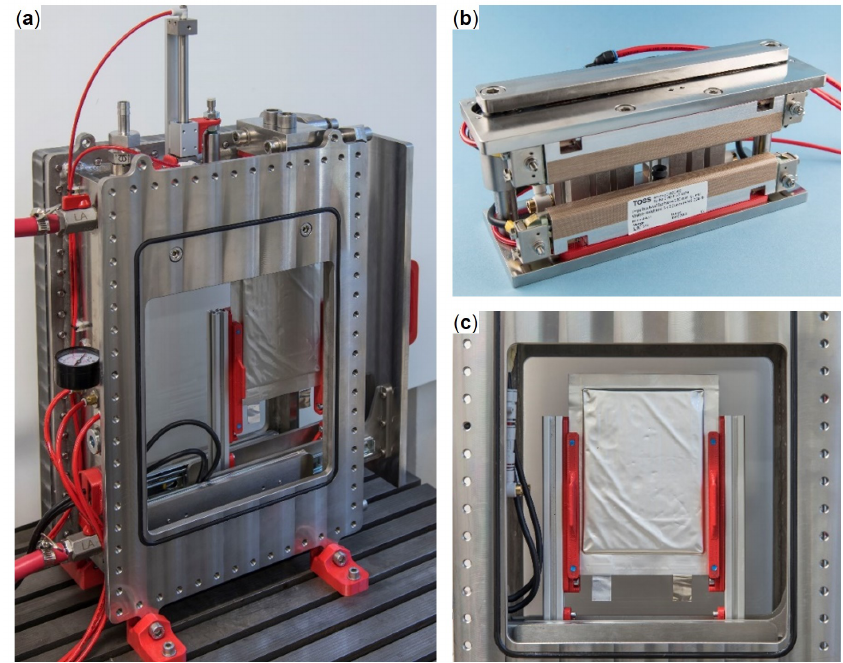
Figure 8. ( a ): X-ray permeable vacuum chamber. ( b ): Impulse sealing system. ( c ): View of a pouch LIB through their permeable (and see through)